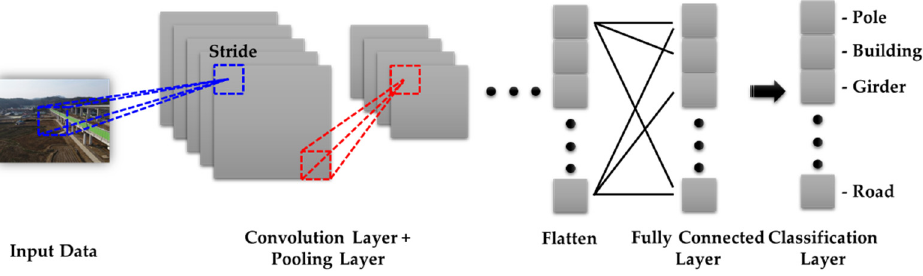
Figure 1. Structure of the CNN.